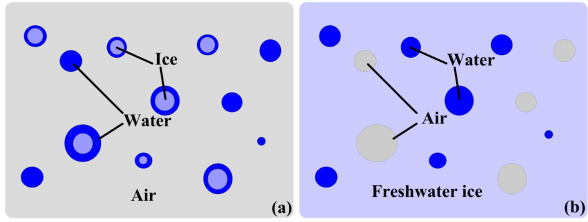
Figure 7. Models of snow cover (a) and lake ice (b)